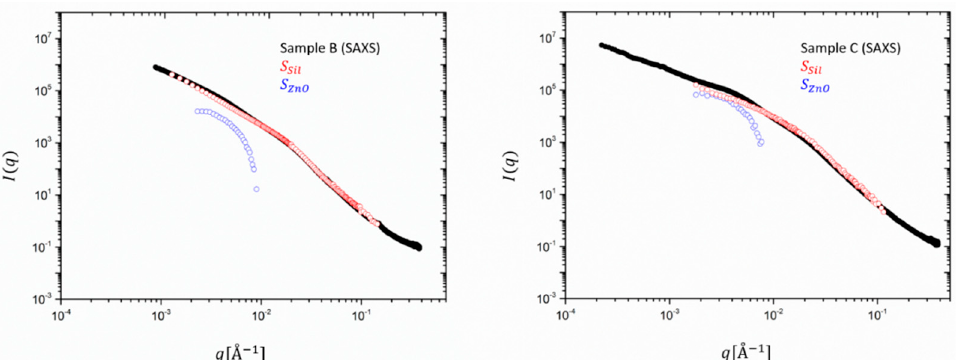
Figure 4. Experimental SAXS data in absolute intensity units cm − 1 for samples B (30 phr) (left) and C (60 phr) (right). Partial form factors for silica ( S pol , red) and ZnO ( S ZnO , blue) were multiplied by the contrast factors to re-construct the intensity.